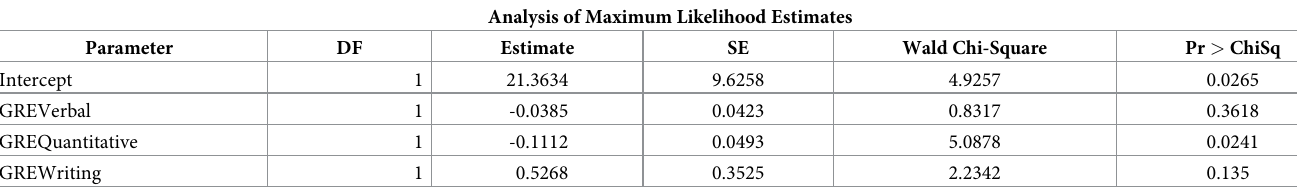
Table 5. Maximum likelihood estimates for domestic dropout from ECE programs (N =